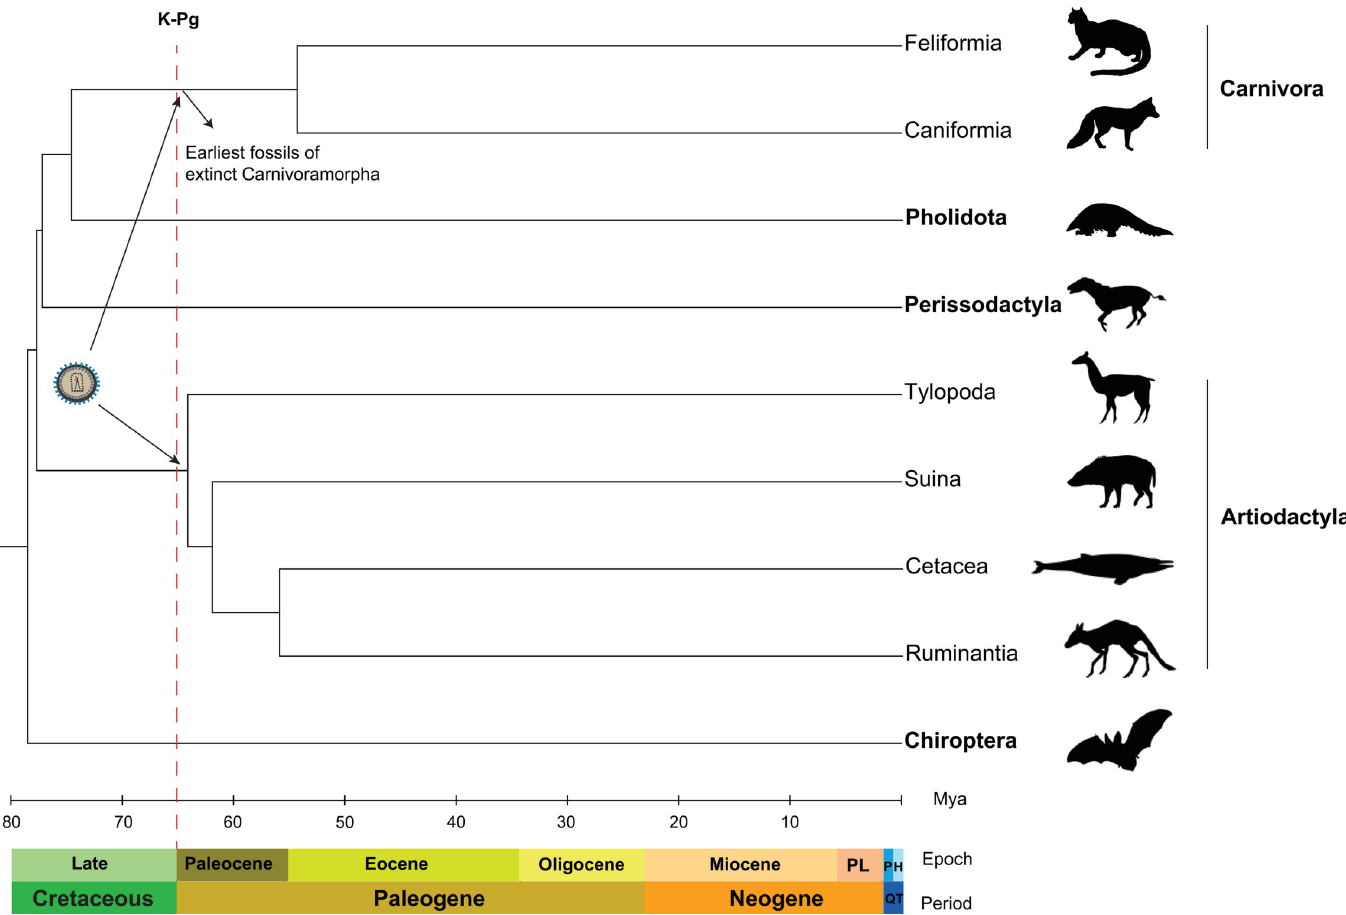
Fig 12. Cross-species transmission of an ancient gammaretrovirus around the K-Pg event. The species cladogram shows the phylogenetic relationships for the indicated orders (in bold) that belong to the superorder Laurasiatheria. Suborders are identified for Carnivora and Artiodactyla. The tree and the divergence times were generated using TimeTree [82]. Geological timescales were derived from The International Chronostratigraphic Chart [119]. PL; pliocene, QT; quaternary, P; pleistocene, H;